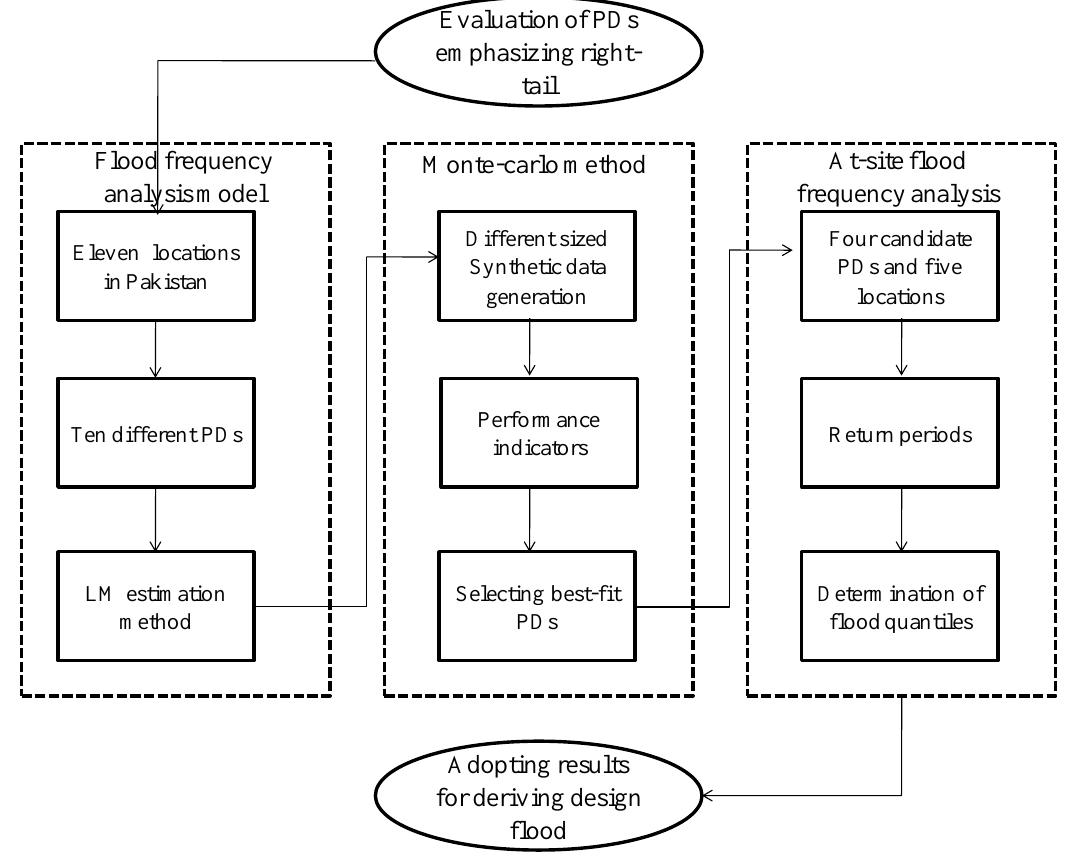
Figure 2. Flowchart of the procedure for evaluating flood quantiles over Pakistan .